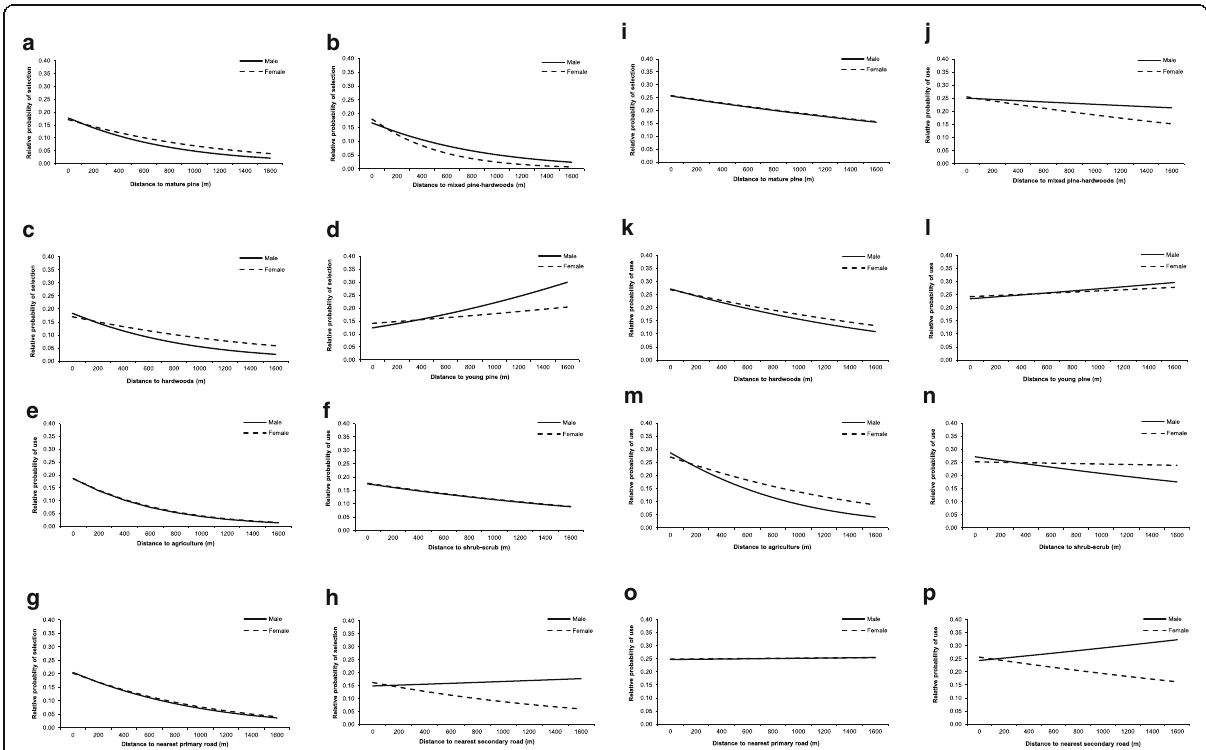
Fig. 3 Relative probability of selection at the landscape and annual area of use spatial scales This research was conducted at the Joseph W. Jones Ecological Research Center, southwestern Georgia, USA, 2001 – 2007. Landscape scale predictive probability figures: mature pine ( a ), mixed pine- hardwoods ( b ), hardwoods ( c ), young pine ( d ), agriculture ( e ), shrub-scrub ( f ), primary roads ( g ), and secondary roads ( h ). Annual area of use predictive probability figures: mature pine ( i ), mixed pine-hardwoods ( j ), hardwoods ( k ), young pine ( l ), agriculture ( m ), shrub-scrub ( n ), primary roads ( o ), and secondary roads ( p